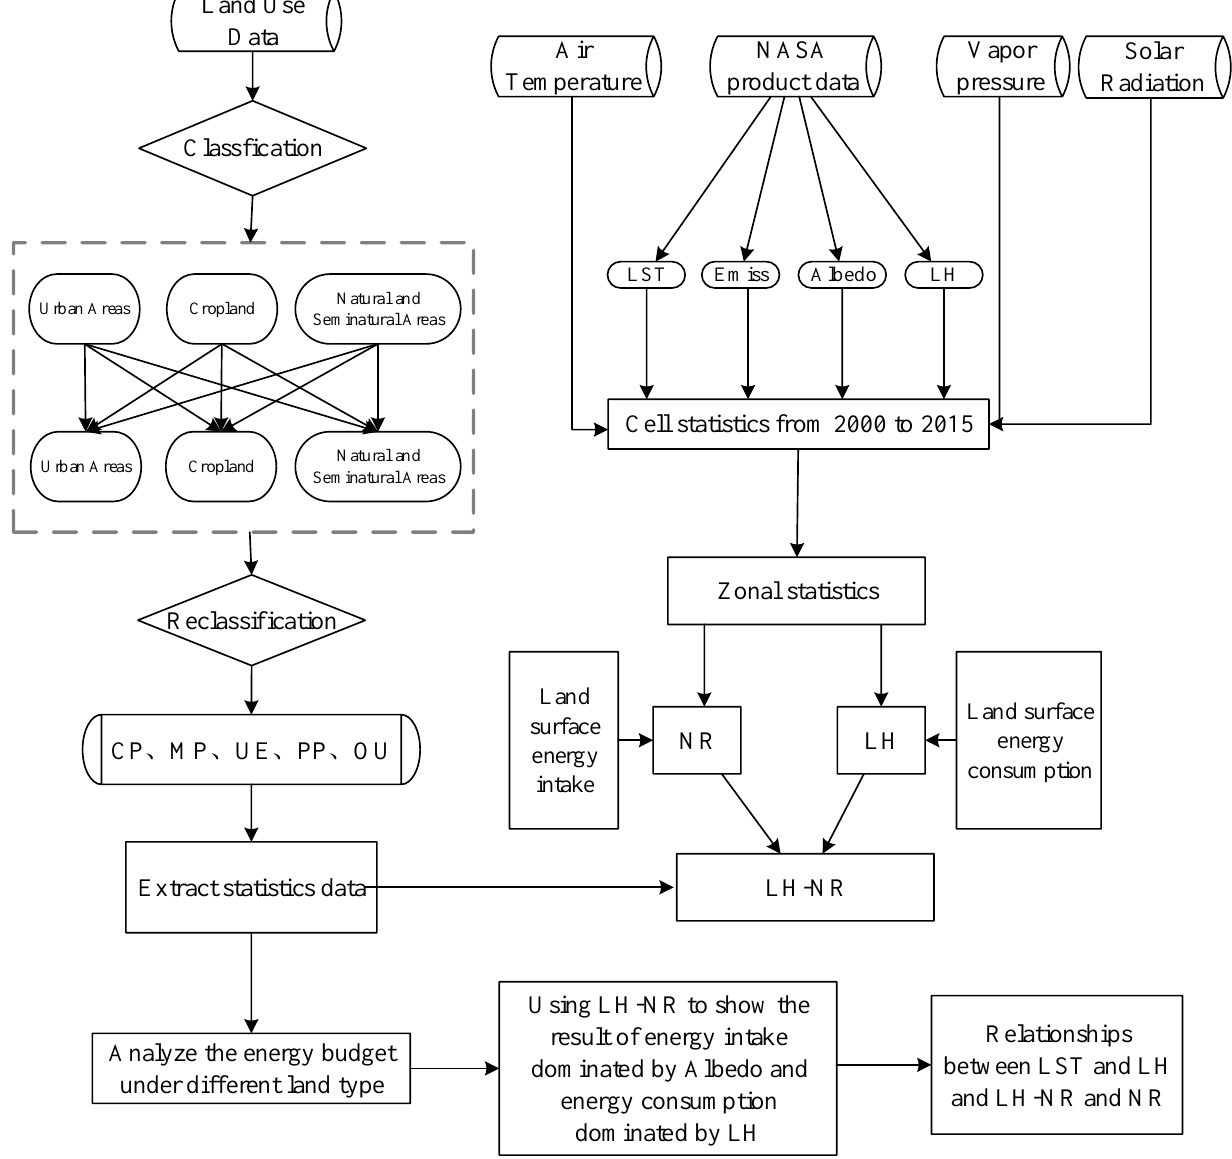
Figure 3. Research framework of energy budget feedback of land use change.